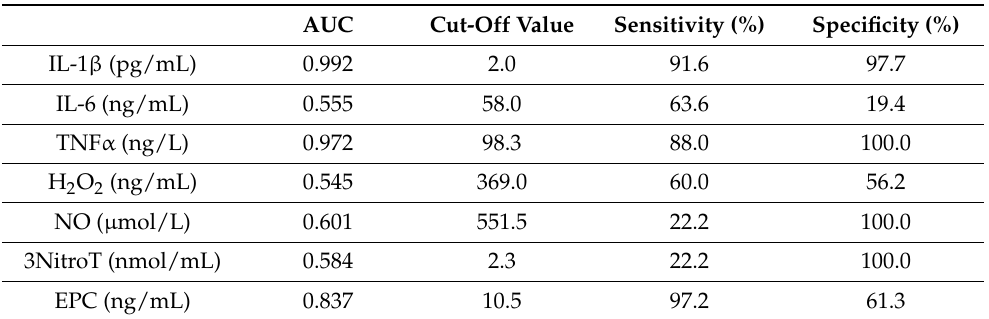
Table 5. The statistical characteristics of the ROC curve for the univariate logistic model for inflam- matory and endothelium-specific variables.